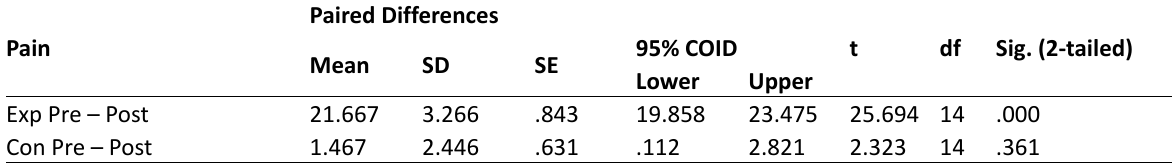
Table 1. Pre and post mean differences of experimental and control group for pain Paired Differences Pain